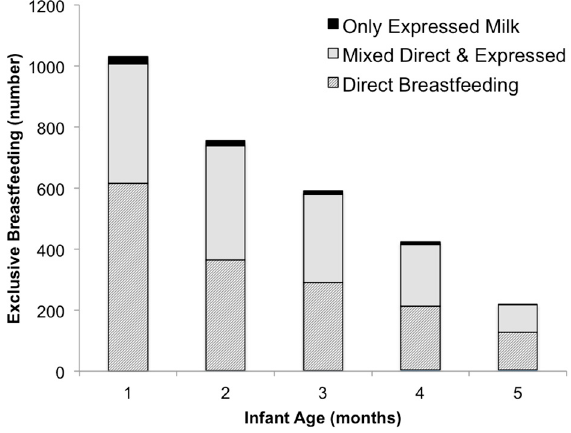
Figure 2. Number of infants who were fed exclusively breast milk each month, and either fed directly at the breast, both directly at the breast and expressed milk, or only expressed breast milk.